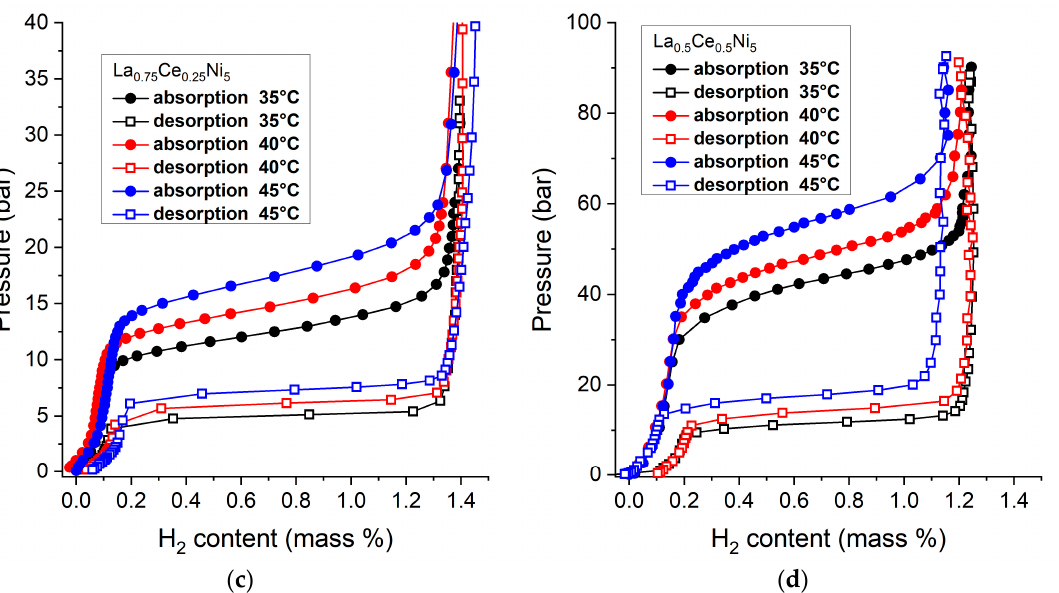
Figure 3. Absorption and desorption isotherms: ( a ) LaNi 5 , ( b ) La 0.91 Ce 0.09 Ni 5 , ( c ) La 0.75 Ce 0.25 Ni 5 and ( d ) La 0.5 Ce 0.5 Ni 5 .